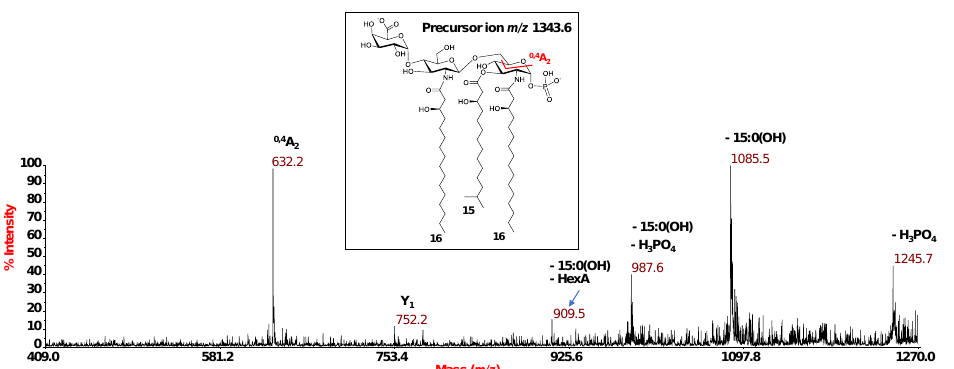
Figure 6. Negative-ion MALDI MS/MS spectrum of precursor ion at m / z 1343.6, a representative ion peak of the cluster ascribed to tri-acylated lipid A species from E. vietnamensis KMM 6221 T . The assignment of fragments is reported. The proposed structure for the lipid A species is sketched in the inset carrying two negative charges for information purposes only in order to underline that both sites of the molecule (i.e., the phosphate and the GalA) may hold the negative charge.